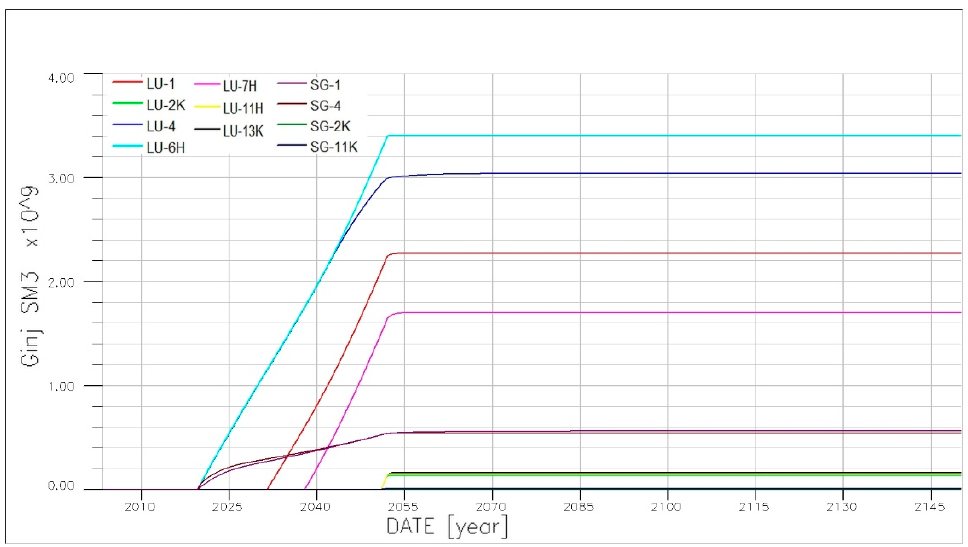
Figure 17. Basic scenario of oil production by enhanced oil recovery (EOR) with CO 2 injection. G in denotes CO 2 total injection of individual wells.